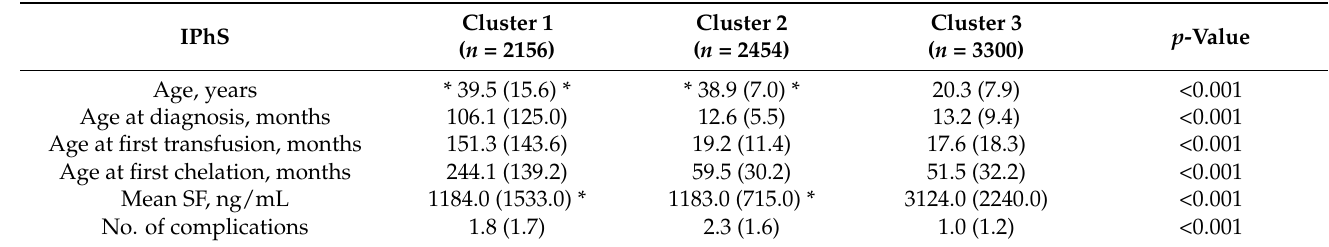
Table 3. Comparison of the six most important indicators of phenotype severity (IPhS) between the three clusters.